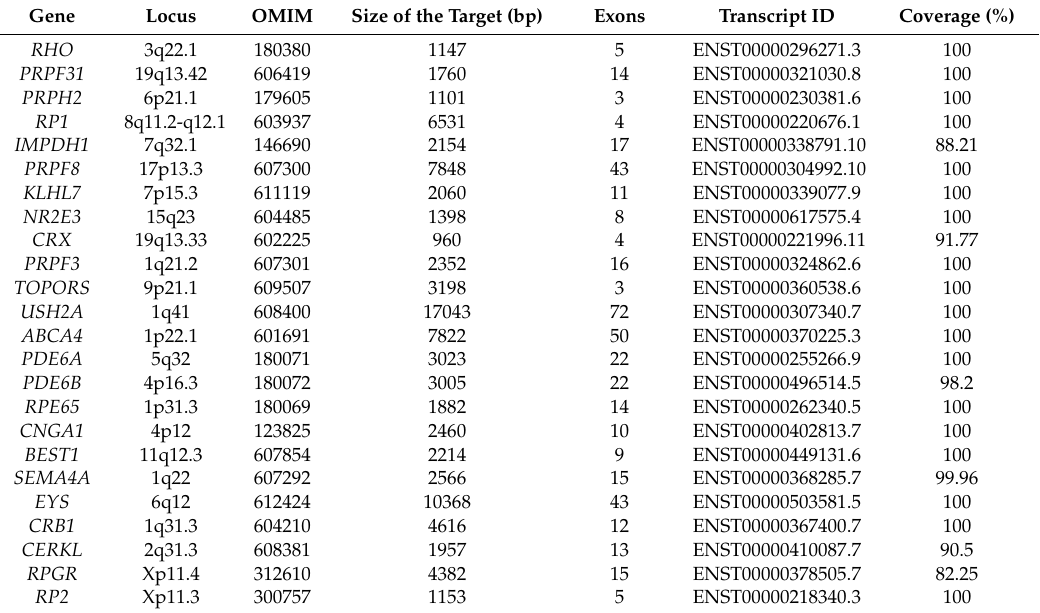
Table 1. Customized NGS panel utilized for molecular diagnosis of RP and other retinal dystrophies. Gene